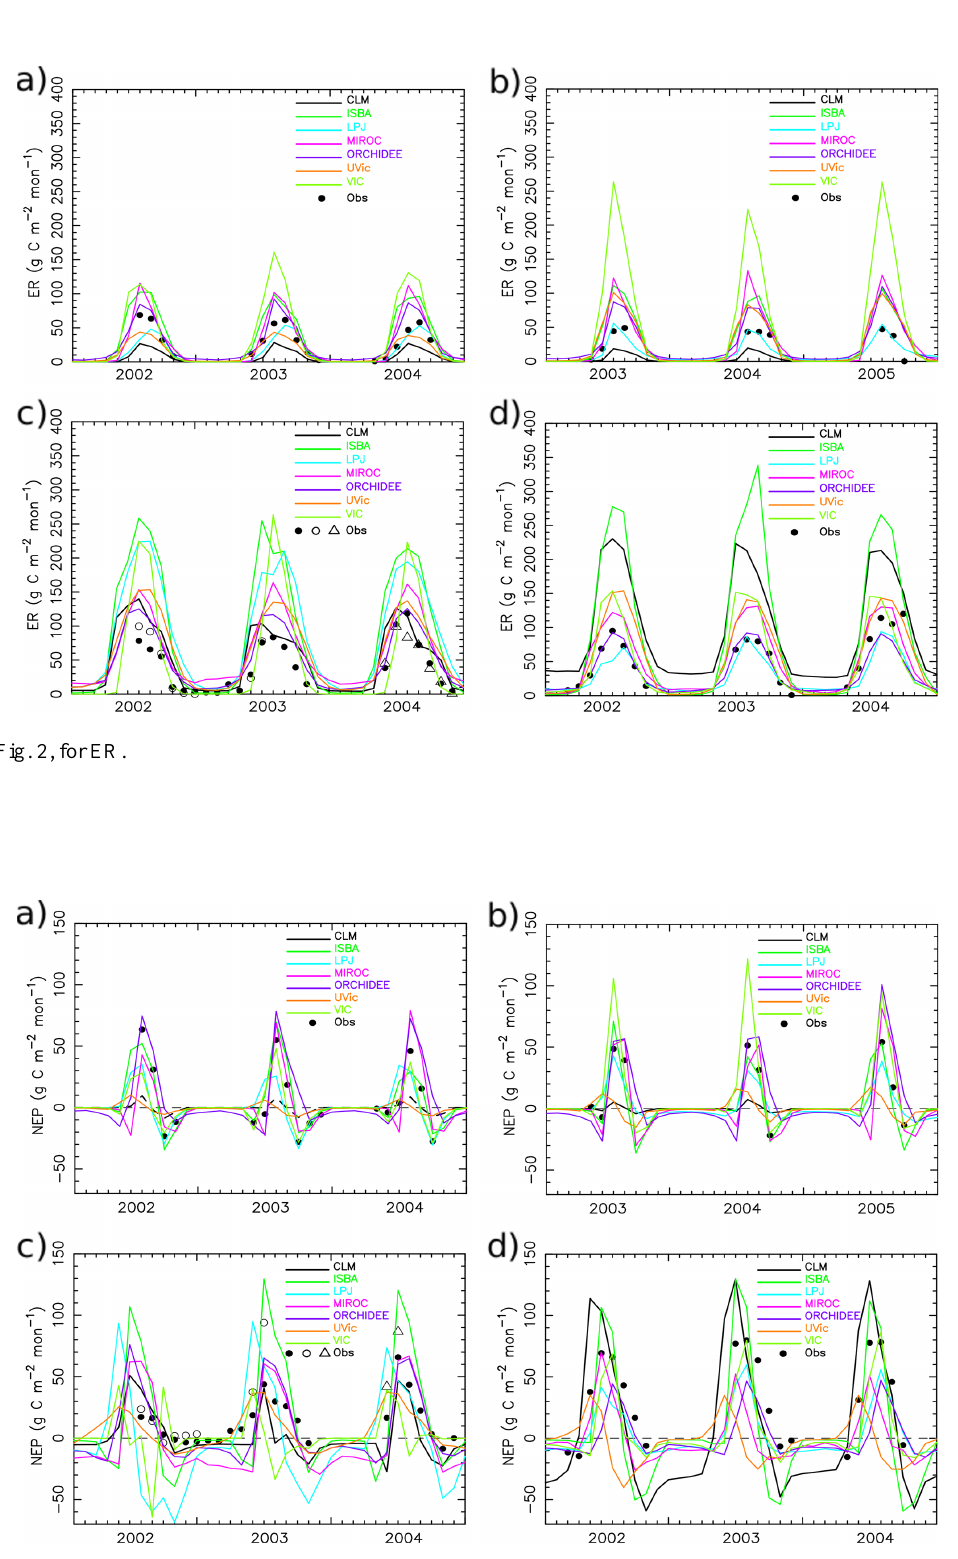
Figure 4. As in Fig. 2, for NEP. NEP = GPP −